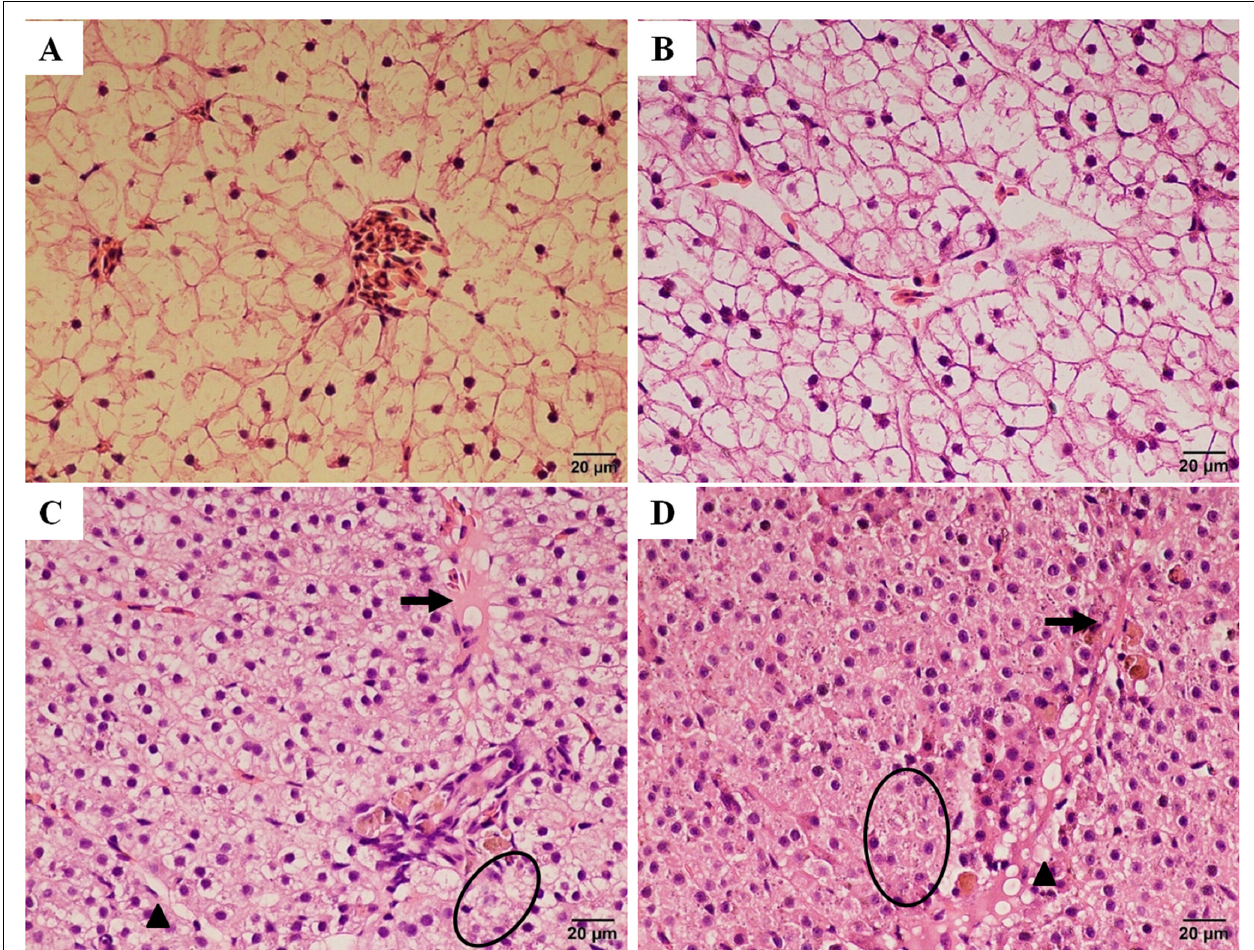
FIGURE 5 | Histopathological changes in the liver of Carassius auratus gibelio after treatment with trichlorfon for 24 h. (A) Liver of control fish; (B) liver of Carassius auratus gibelio after oral administration of 0.5 g/kg trichlorfon; (C) oral administration of 1 g/kg trichlorfon; and (D) oral administration of 2 g/kg trichlorfon. Vacuolar degeneration (triangle), necrosis (circle), and congestion of the central vein